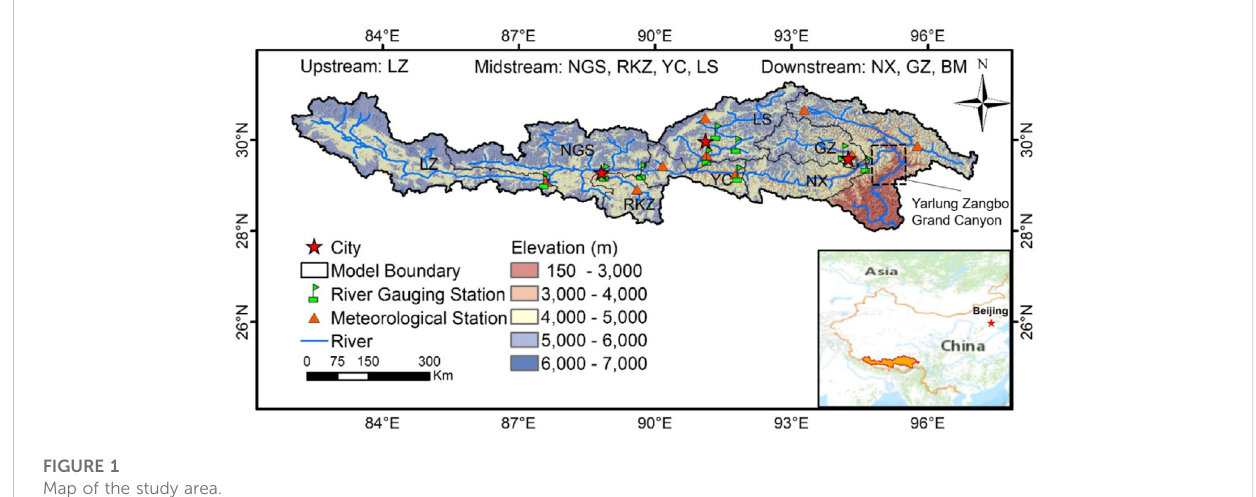
FIGURE 1 Map of the study